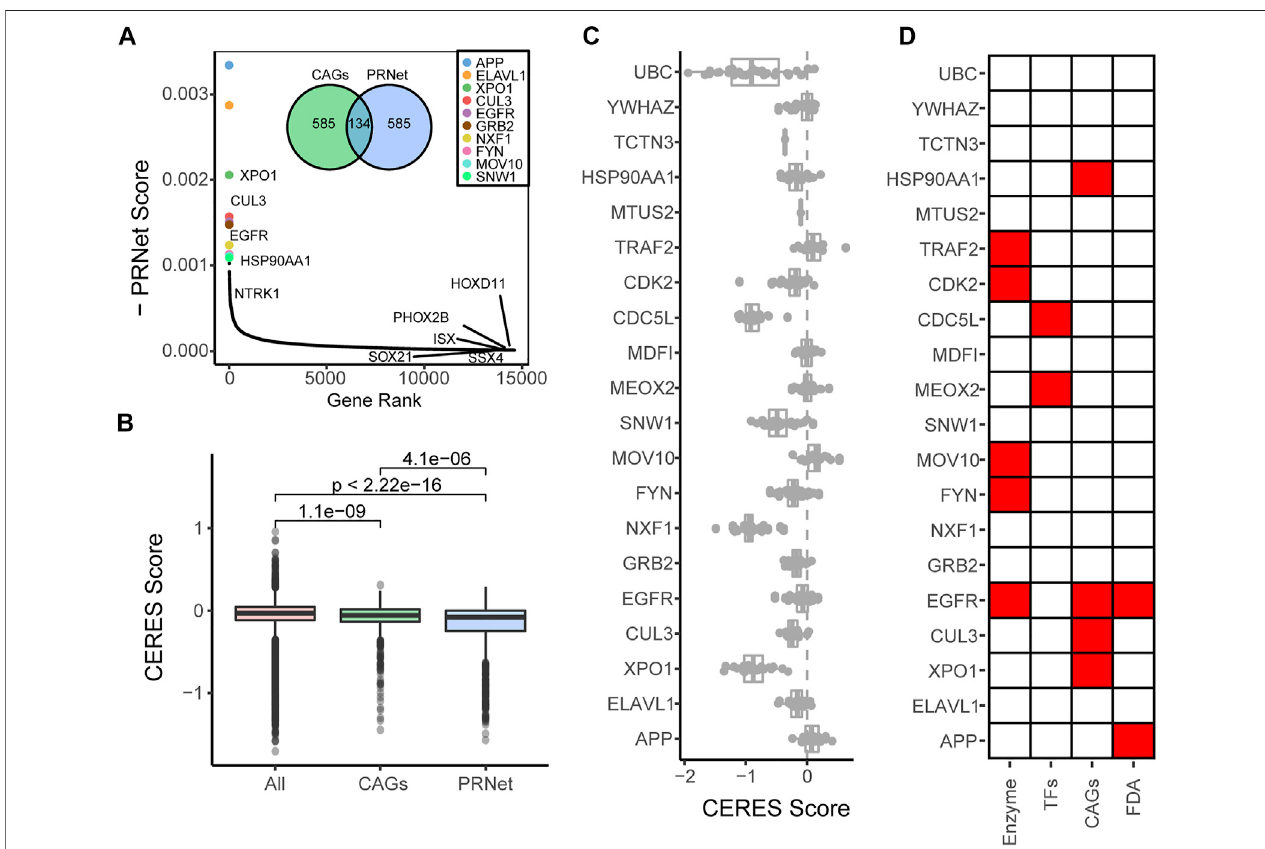
FIGURE 2 | Novel PAAD candidates ’ features. (A) The distribution of the known CAGs after reordering. (B) The CERES scores of the top 719 genes and the CAG list relative to all genes. (C) The CERES score distribution of the 20 top-ranked genes. (D) Functional annotation of the 20 top-ranked genes.